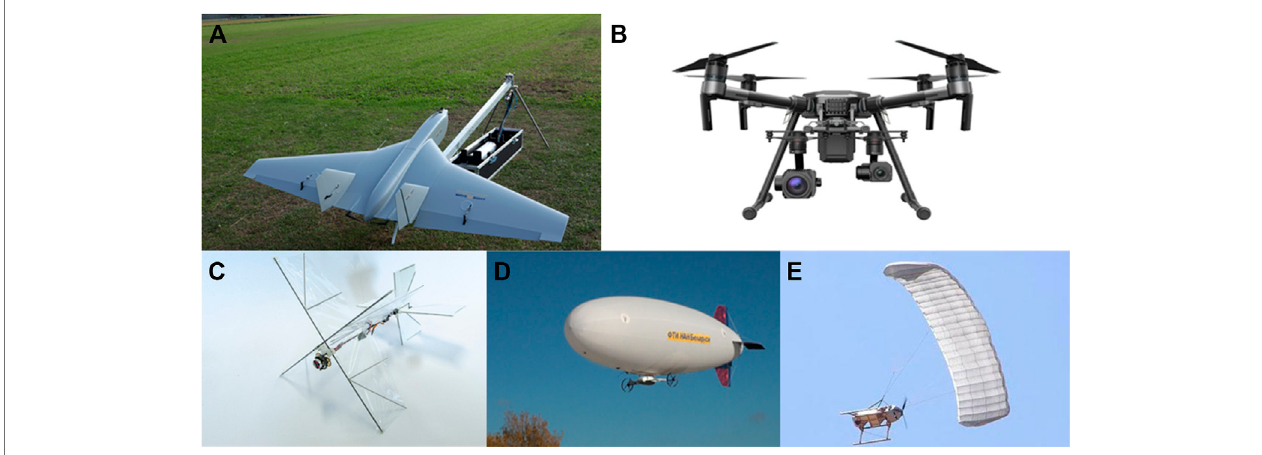
FIGURE 3 | Different types of UAVs: (A) fi xed wing (Volt Aerial Robotics, 2016), (B) rotary wing (Geospatial Media and Communications, 2018), (C) fl apping wing (Tzu-ti, 2020), (D) unmanned airship (Unmanned airship, 2014), and (E) parafoil UAV (Lanny Lin, 2021).